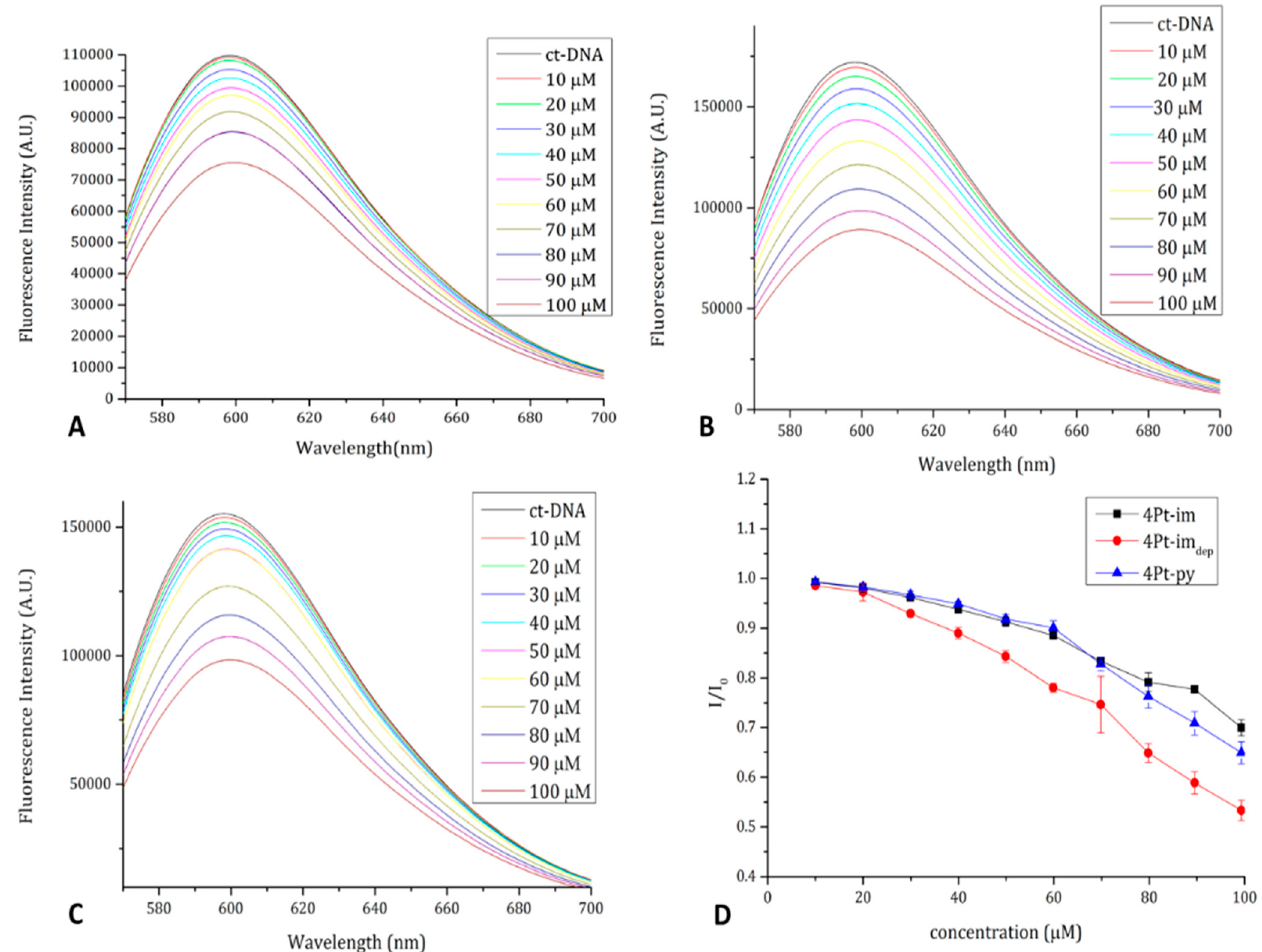
Figure 10. Fluorescence emission spectra of the ct-DNA-EtBr complex upon titration with a solution of 4Pt-im ( A ), 4Pt-im dep ( B ), and 4Pt-py ( C ), In panel ( D ), I/Io as a function of compound concentration is reported.